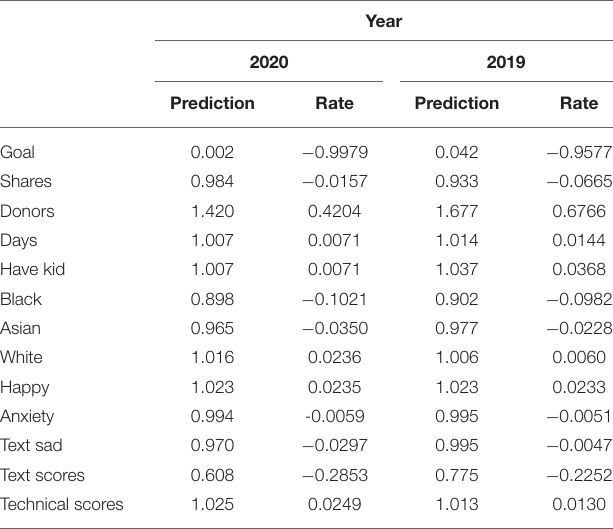
TABLE 6 | Counterfactual analysis experiments for important